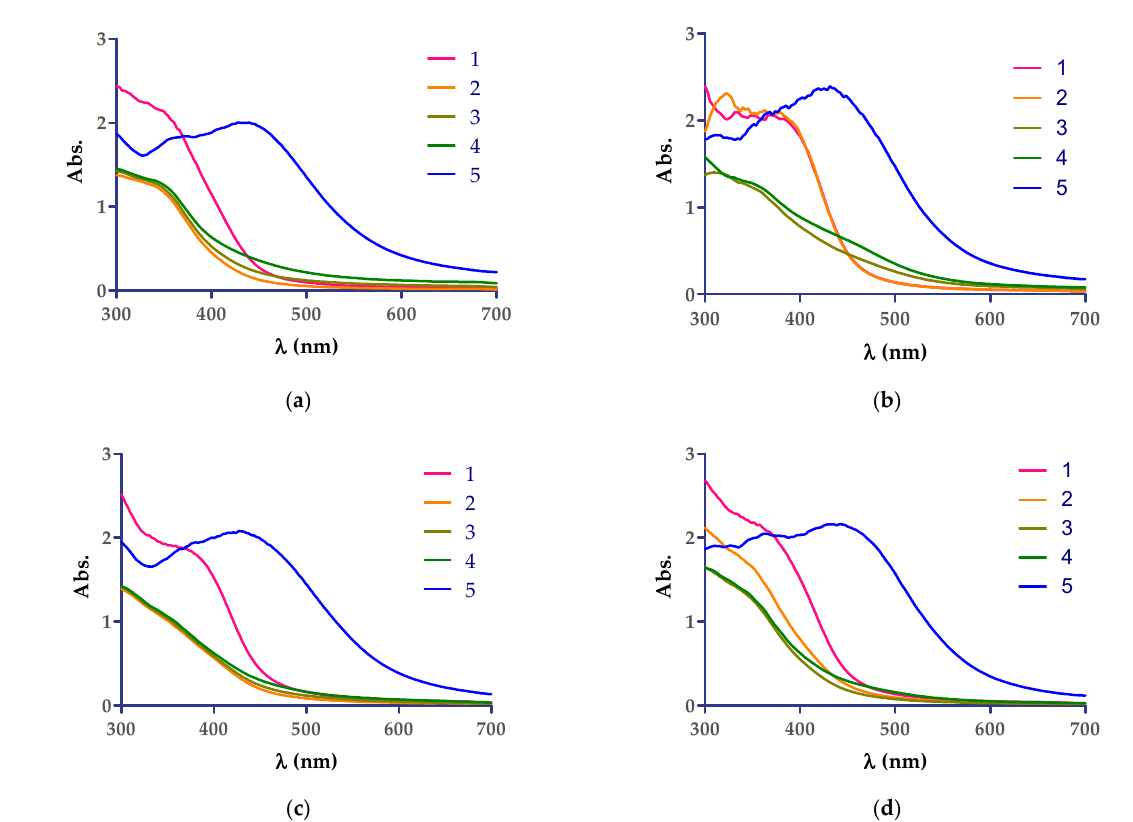
Figure 1. UV − VIS spectra showing the development of AgNPs by Cannabis sativa extracts: ( a ) CsDi, ( b ) CsDe, ( c ) CsSf, and ( d ) CsSm. The correspondence of the curves are as follows: 1 (red)—aqueous solution extract diluted 1:2 with distilled water; 2 (yellow)—mixture of extract + AgNO 3 5 mM after 1 min reaction time at room temperature; 3 (grey)—mixture of extract + AgNO 3 5 mM after 30 min reaction time at room temperature; 4 (green)—mixture of extract + AgNO 3 5 mM after 60 min of reaction time at room temperature; 5 (blue)—mixture of extract + AgNO 3 5 mM after 8 min reaction time at 90 °C.